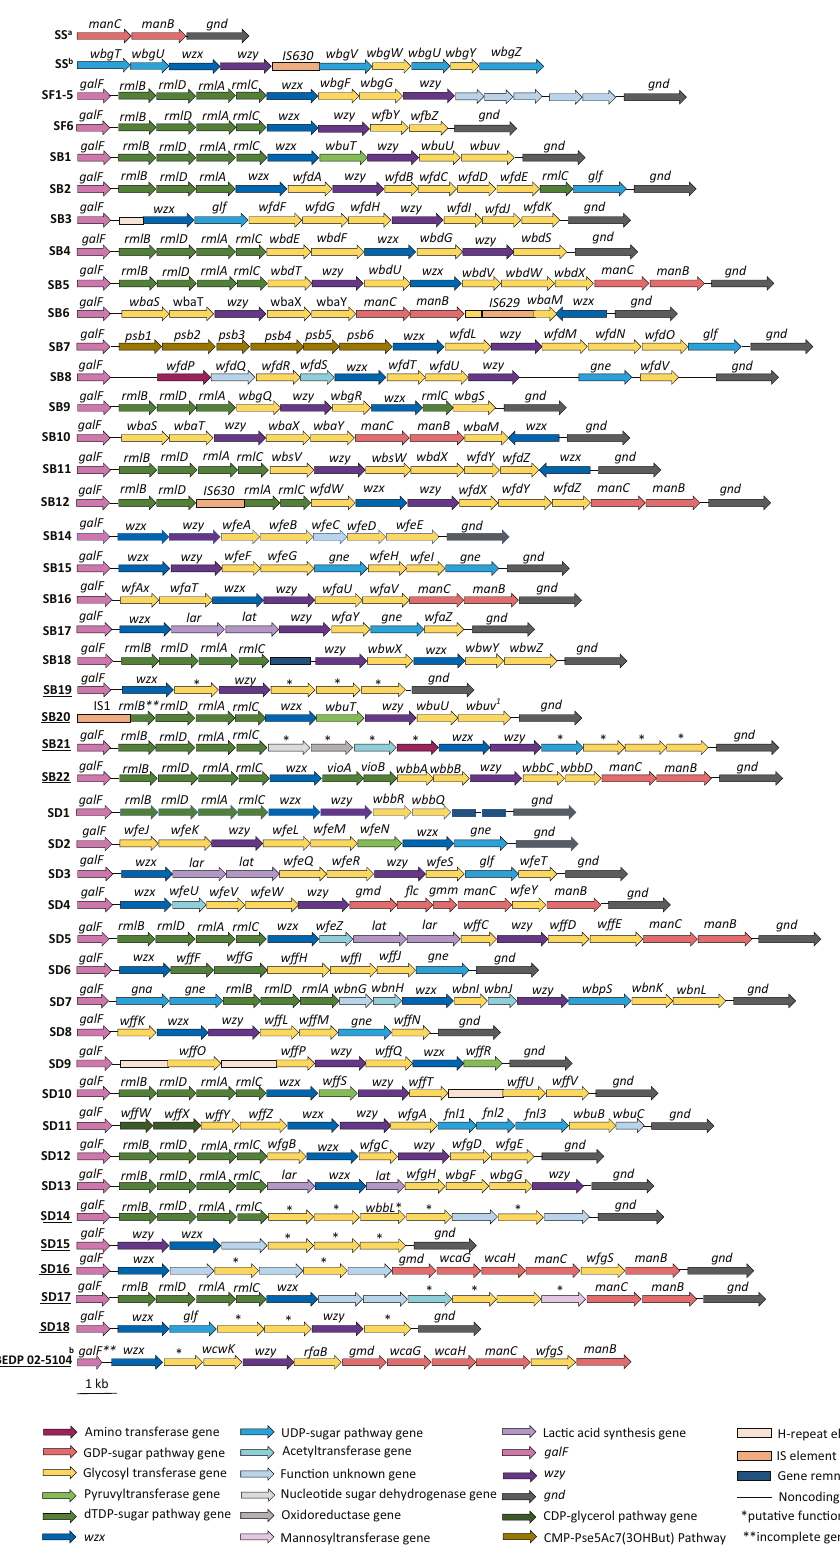
Fig. 6 Representation of all previously and newly characterised Shigella O-antigen gene clusters. The names underlined correspond to those presented for the fi rst time. Open arrows represent the location and orientation of putative genes. SS a is a chromosomal remnant rfb from S. sonnei . A b in superscript indicates that the cluster is located on a plasmid. A 1 in superscript indicates that the gene may be truncated by an IS 1 in some strains. NATURE COMMUNICATIONS| (2022) 13:551